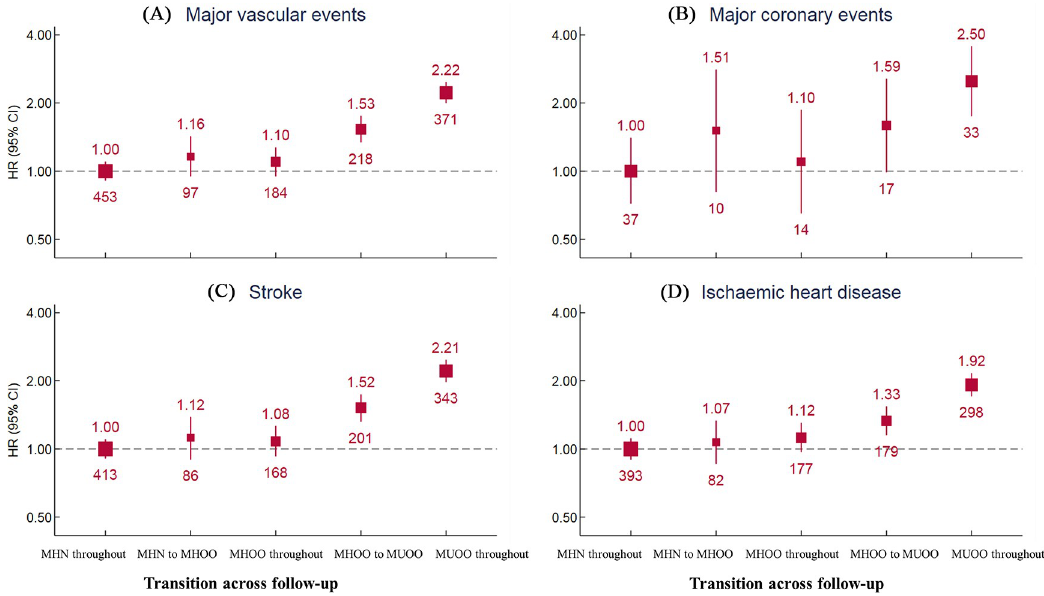
Fig 4. Transition from metabolically healthy to unhealthy status and association with cardiovascular diseases subtypes risk. Values shown are the HR (95% CI) for (A) major vascular events, (B) major coronary events, (C) stroke, and (D) ischemic heart disease, by transition of BMI-metabolic health status. HRs are adjusted for age, study region, sex, education, household income, marital status, smoking, alcohol use, red meat intake, fresh fruits intake, fresh vegetables intake, physical activity, and family history of heart attack or stroke. Individuals with prior stroke, coronary heart disease, cancer are excluded from all analyses. BMI, body mass index; CI, confidence interval; HR, hazard ratio; MHN, metabolically healthy normal weight; MHOO, metabolically healthy overweight or obesity; MUOO, metabolically unhealthy overweight or